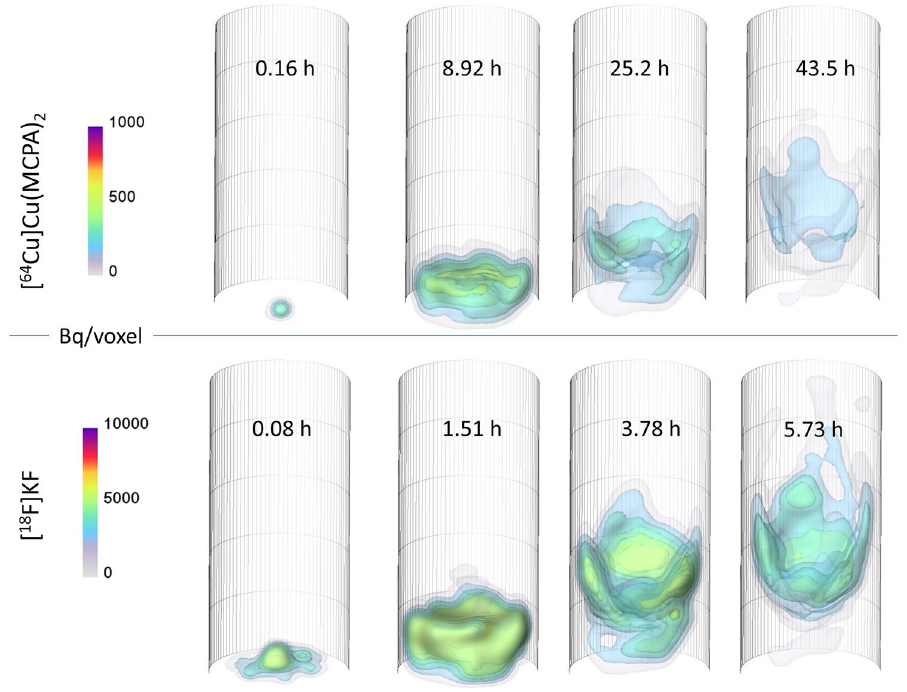
Figure 3. Time-resolved positron emission tomography (4D PET) images acquired during the propagation of a tracer pulse showing non-uniform flow phenomena in an artificial soil column. The tracer distributions are shown as overlaid isosurfaces. The top four images show retarded transport of 64 Cu radiolabeled Cu-MCPA complex, and the lower images show the transport of 18 F-labeled KF as a reasonably conservative reference solute. The selected images represent comparable stages of propagation but were taken at different times. Full movies of all four test column experiments are downloadable as mpeg-4 video file from Supplementary